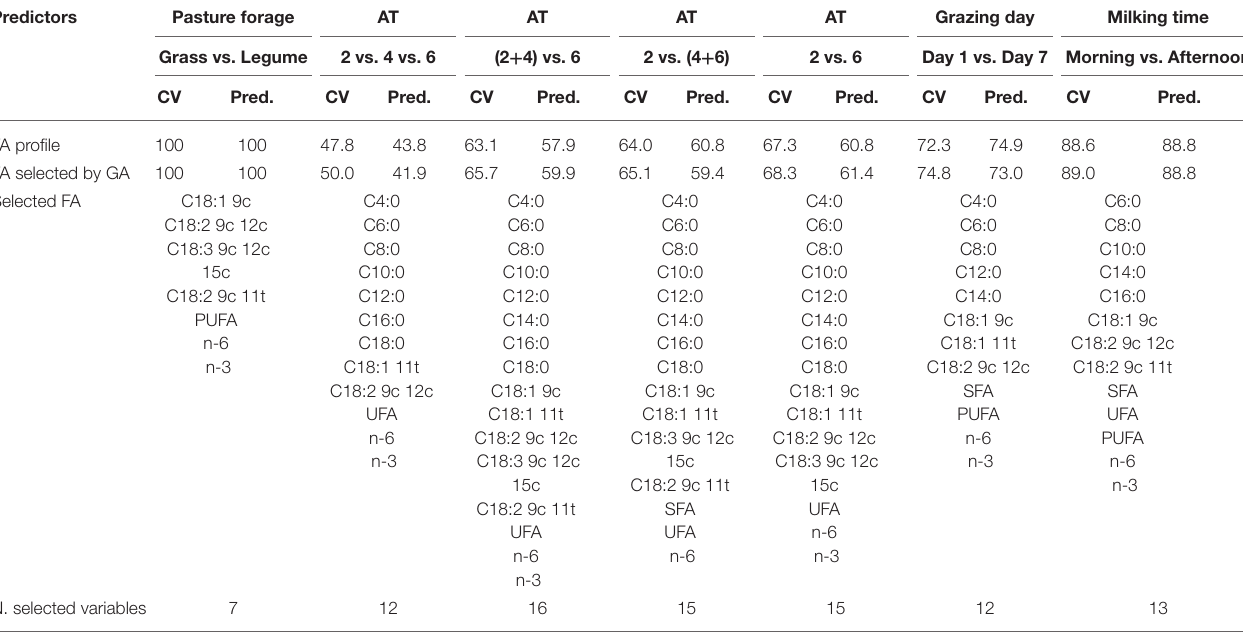
TABLE 4 | Percentage of correct classifications obtained by linear discriminant analysis (LDA) using the fatty acid (FA) profile or the FA selected by genetic algorithm (GA) as predictors. Predictors Pasture forage AT AT AT AT Grazing day Milking